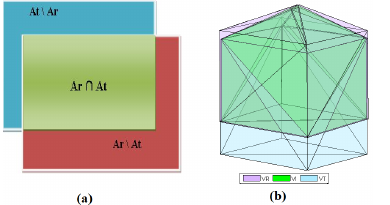
Figure 1: Relationship between reference and tested models in 2D (a) and 3D (b).